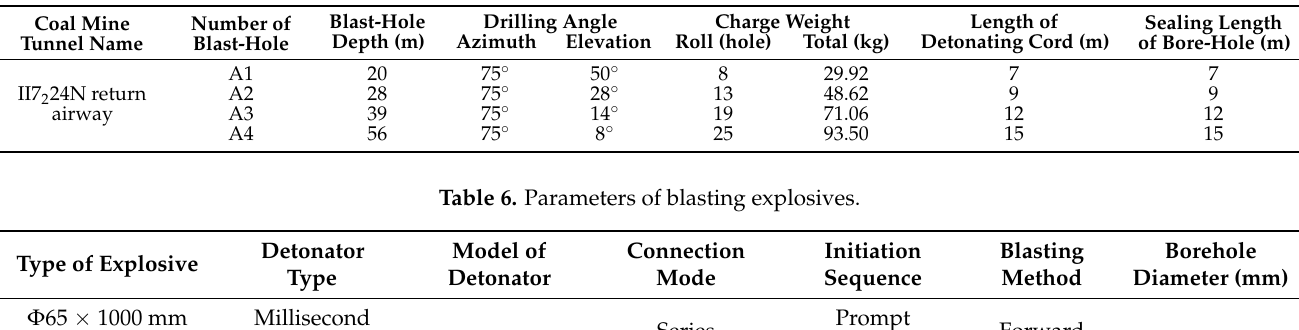
Table 5. Parameters of blast-hole and charge weight.